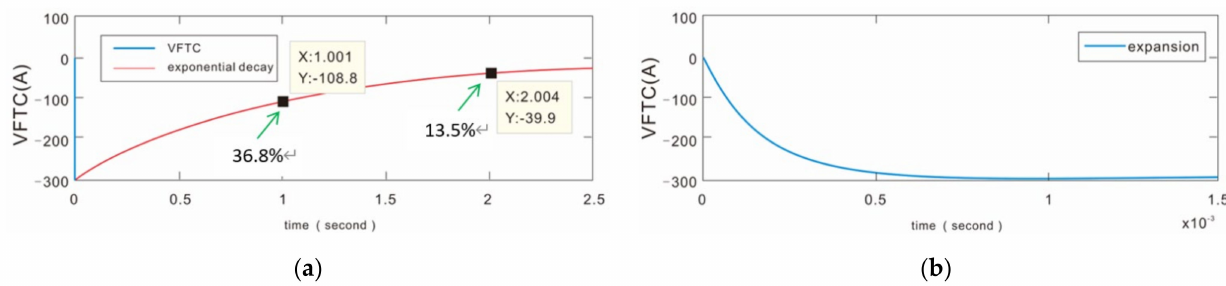
Figure 9. The wave shapes of VFTC Output of filter (AD sampling) and its expansion (S. No4). ( a ) VFTC waveforms; ( b ) the expansion of VFTC